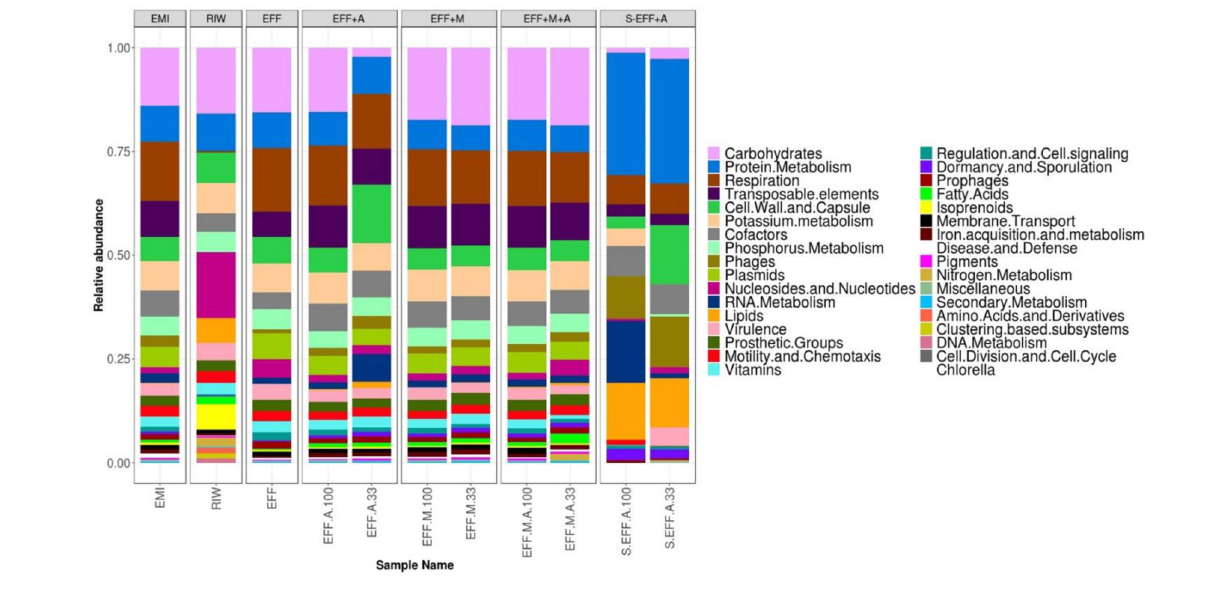
FIGURE 7 | Distribution of functional profiles . The functions were identified using SEED classification. The enriched microbial inoculum (EMI) showed a similar functional profile compared to that of the dark fermentation effluent (EFF) despite their highly different taxonomic